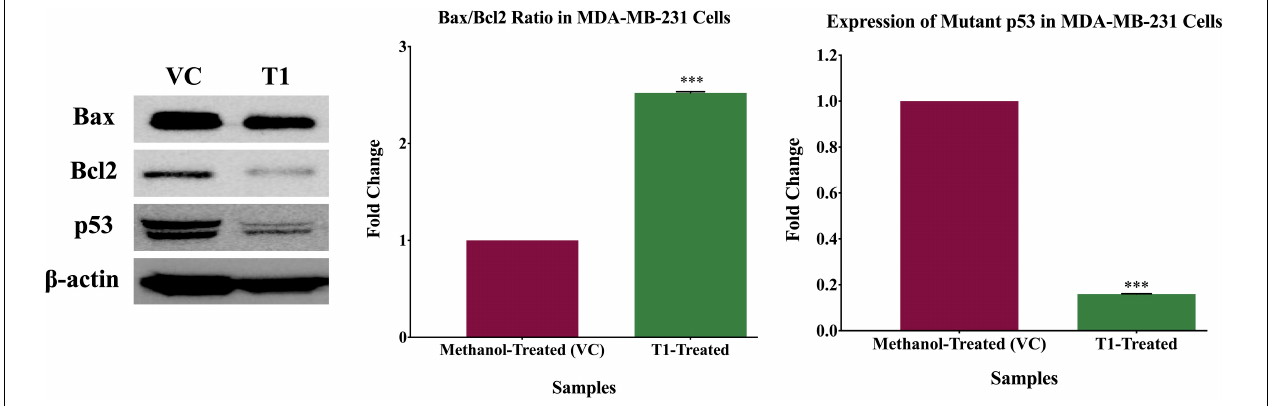
FIGURE 6 | Expression patterns of proteins associated with T1-induced apoptosis. Western blot analysis of T1 extract- inhibited mutant p53 expression, while upregulating Bax/Bcl ratio, in comparison with their vehicle control (VC). β -actin was used as a control for the proteins amount in this assay. Cells were treated with 5% of T1-extract for 48 h, as explained in the materials and methods and the results sections. *** p <